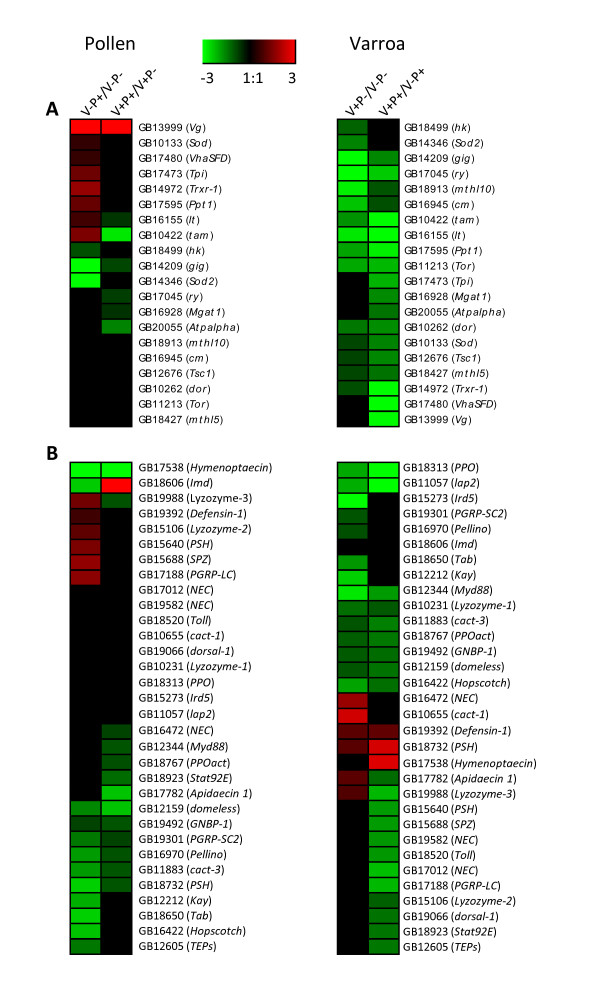
Immune and lifespan genes affected by pollen feeding or varroa parasitism. A) Genes from our gene sets that are involved in lifespan in Drosophila and honey bees (i.e. Vg). B) Immune genes found in honey bees (the list of genes originated from [42]). Colors scale from the heatmap (green to red) indicates log2 transcription ratios. For each gene, accession number and annotation are indicated.